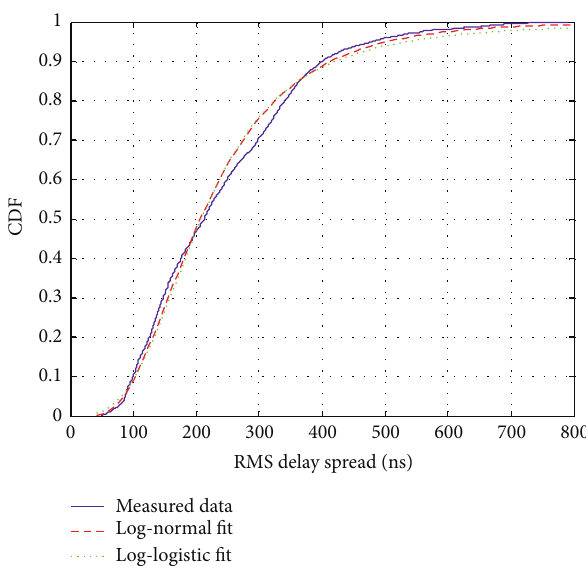
Figure 4: CDF of RMS delay spread values in HSR hilly